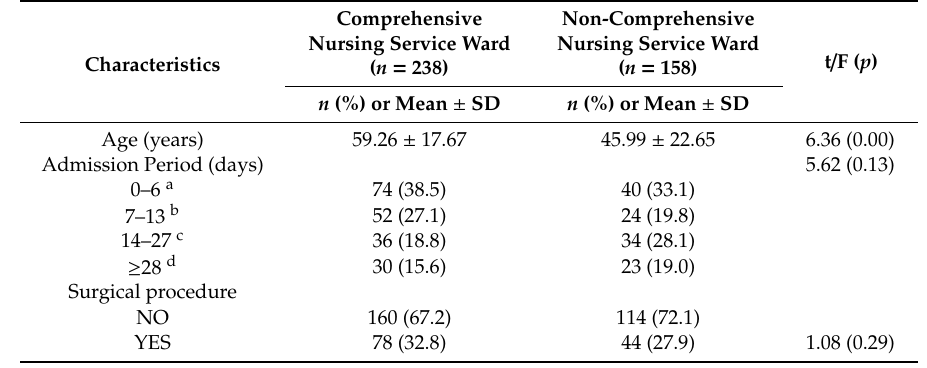
Table 4. Descriptive Statistics of General Characteristics of Patients ( n = 396).